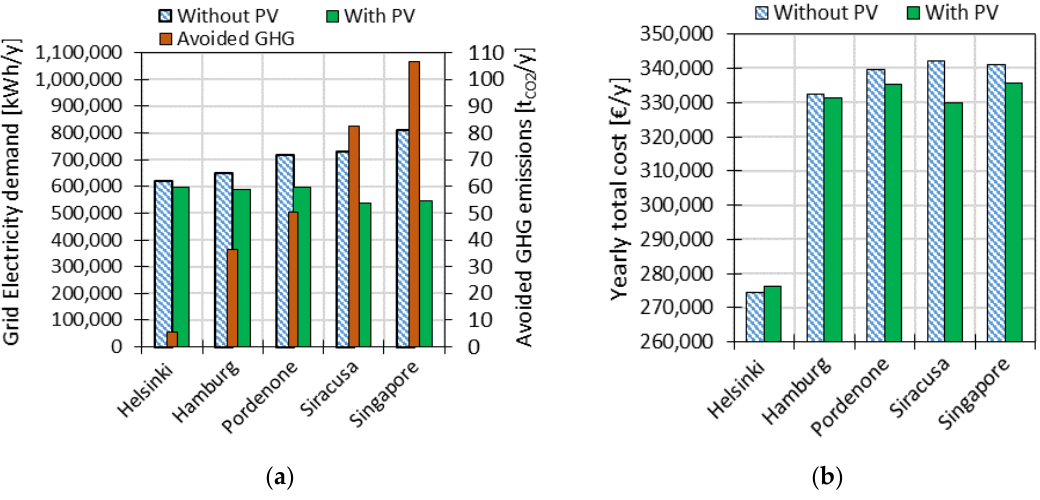
Figure 13. Impact of location on warehouse performance: ( a ) grid electricity demand and avoided GHG emissions; ( b ) yearly total cost.